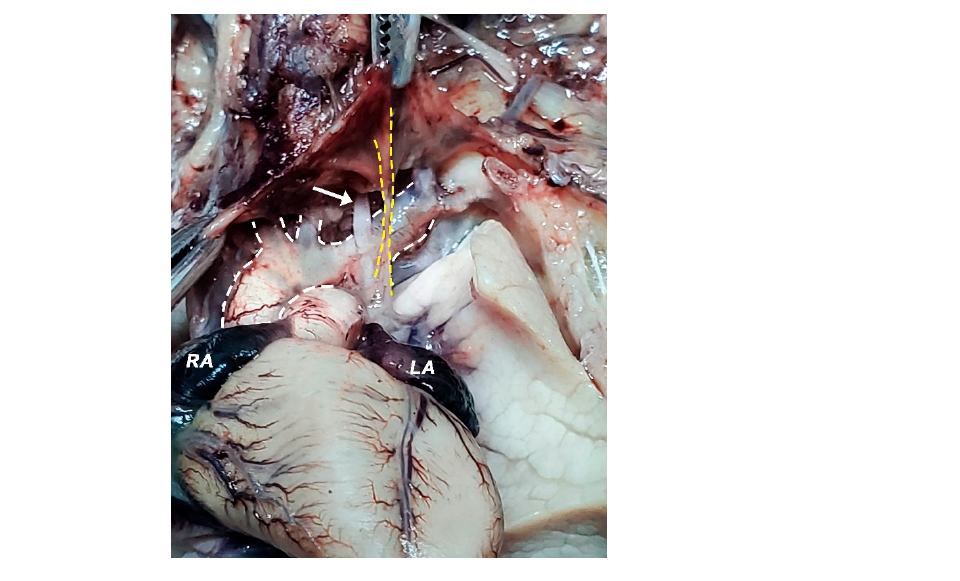
Figure 10. Heart, the greater vessels of the heart, front view; brachiocephalic veins set aside (forceps). White dashed lines highlight the aortic arch and the vessels emerging from it; the left subclavian artery appears dilated, its diameter being comparable with the caliber of the aortic arch itself; Yellow dashed lines highlight the arteriovenous anastomosis (top forceps) descending anterior to the left subclavian artery and left from the vagus nerve (white arrow); LA—left auriculum; RA—right auriculum.